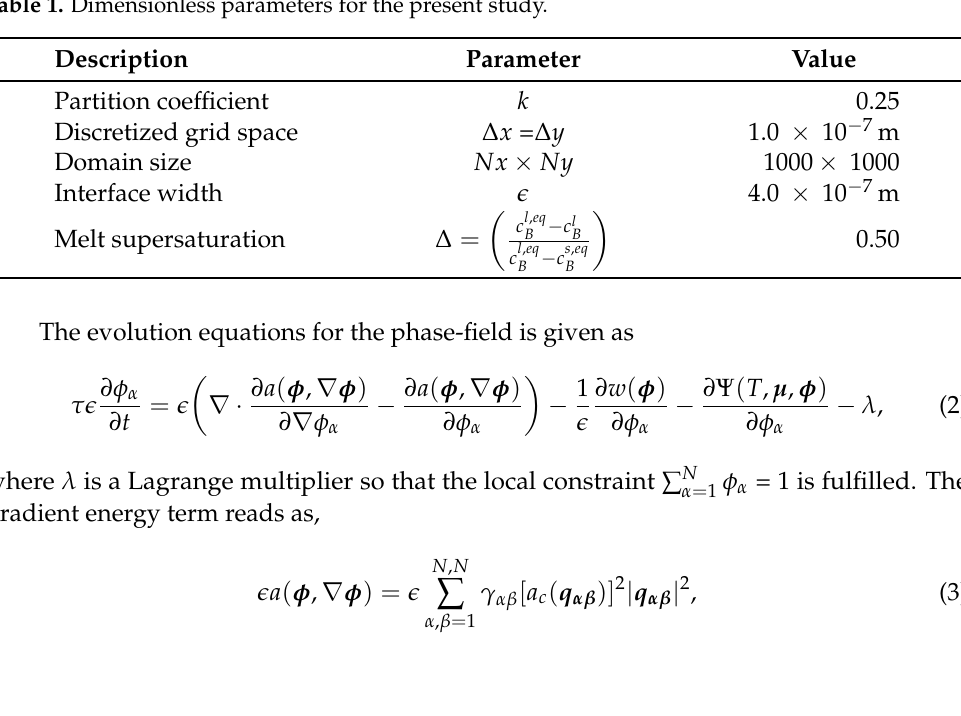
Table 1. Dimensionless parameters for the present